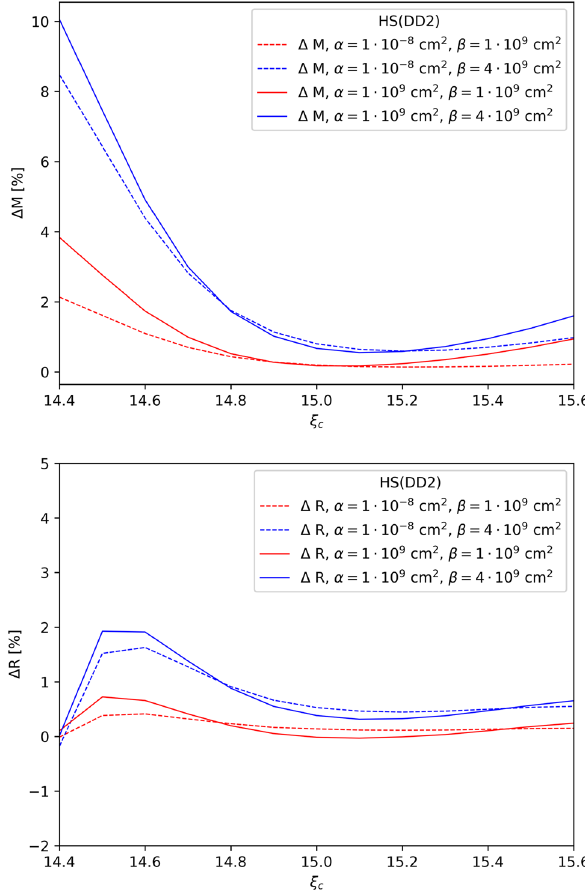
Fig. 15 Difference between the mass (upper panel) and the radius (lower panel) obtained, given a central density value ξ , with f ( R , Q ) = R + α R 2 + β Q and GR, for the FPS EoS